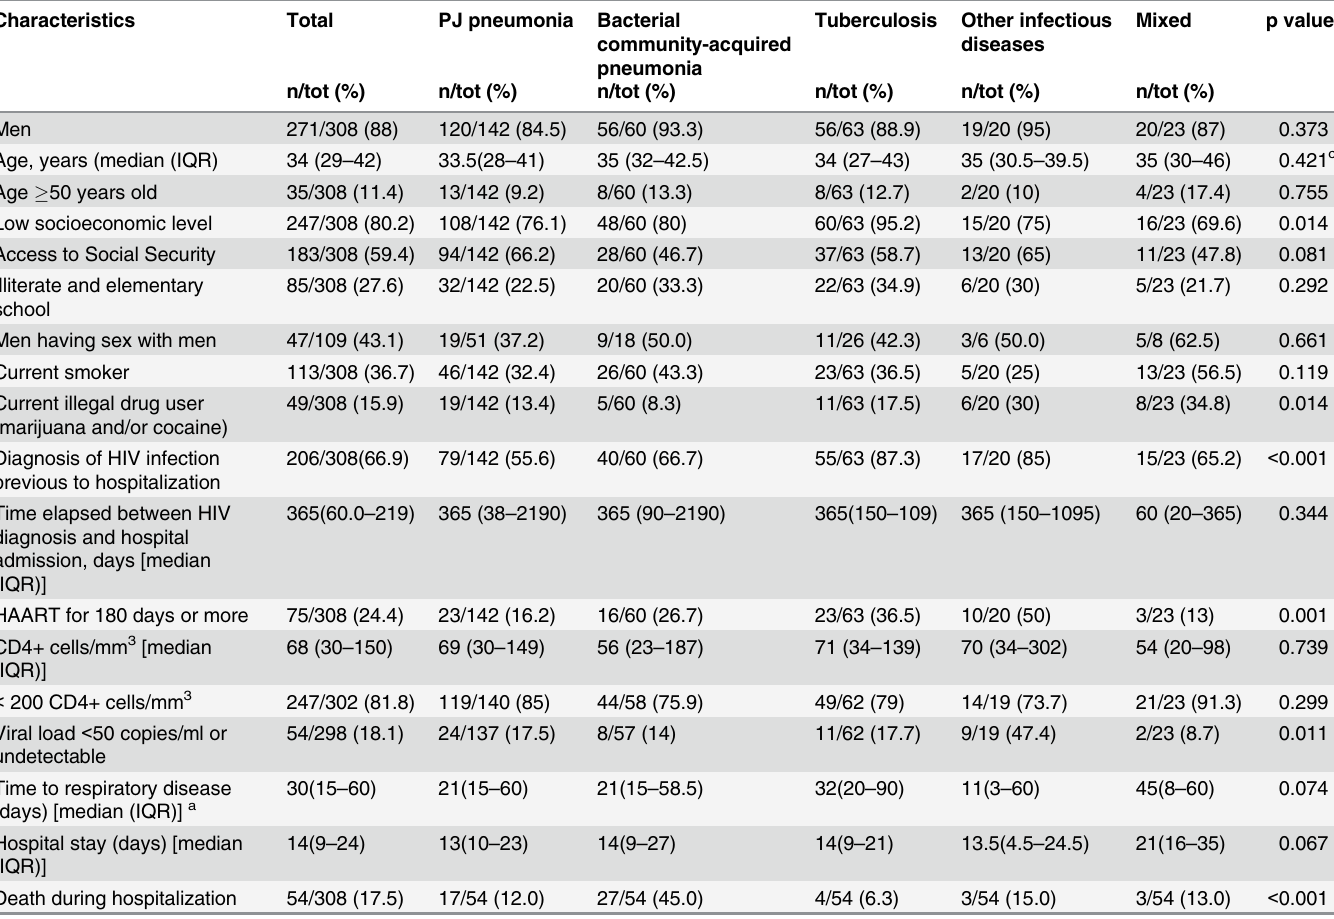
Table 1. Characteristics of HIV/AIDS patients in a reference hospital for respiratory diseases in Mexico City, from January 2010 to December 2010, according to discharge respiratory diagnoses.